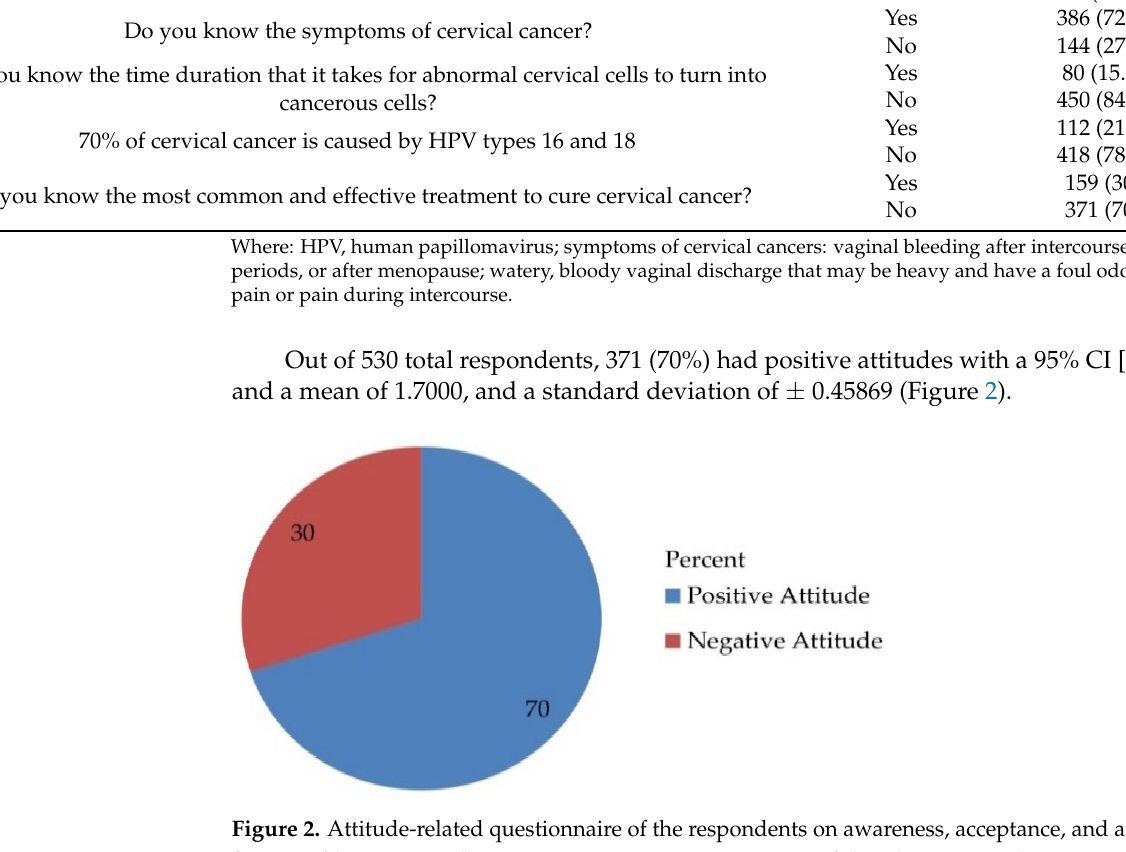
Table 3. Attitude-related questionnaire of the respondents on awareness, acceptance, and associated factors of human papillomavirus vaccine among parents of daughters in Hadiya zone, southern Ethiopia, 2021 (n = 530). Variables